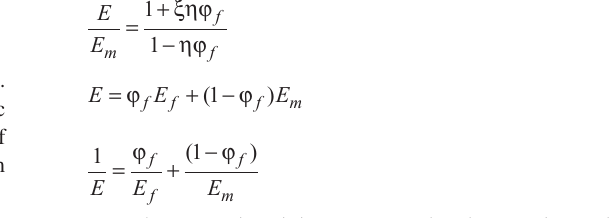
Figure 3. a) EDS and b) FTIR results of calcium carbonate nanoparticles.